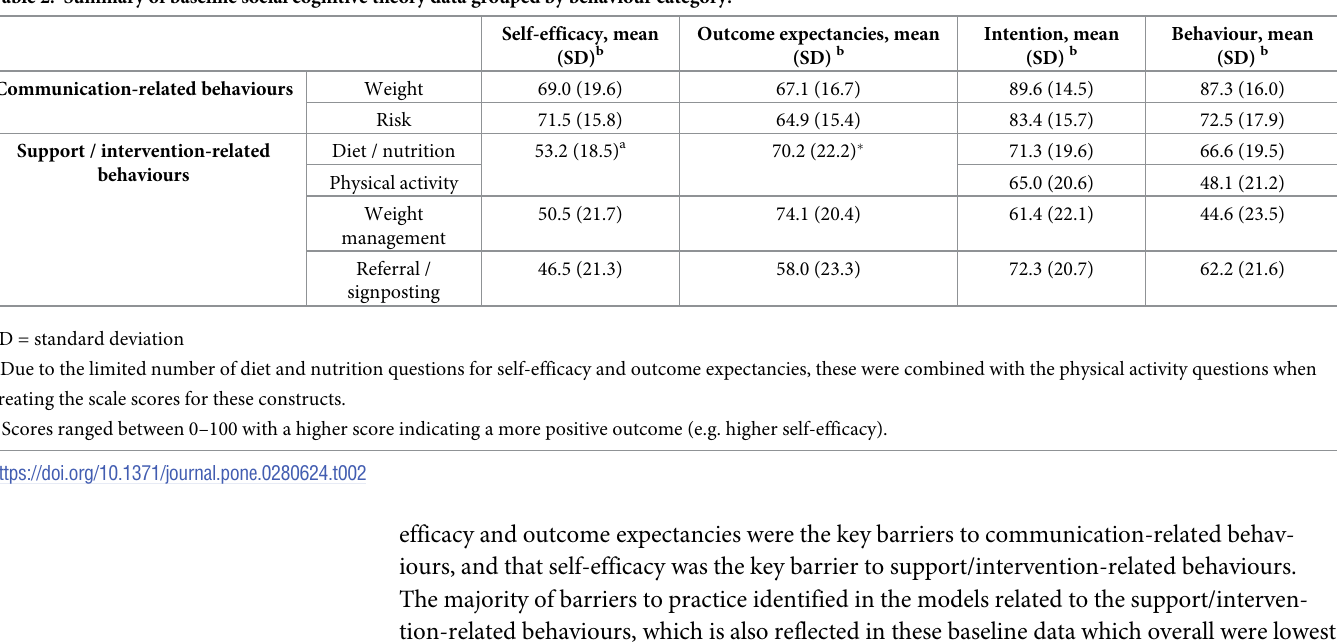
Table 2. Summary of baseline social cognitive theory data grouped by behaviour category.